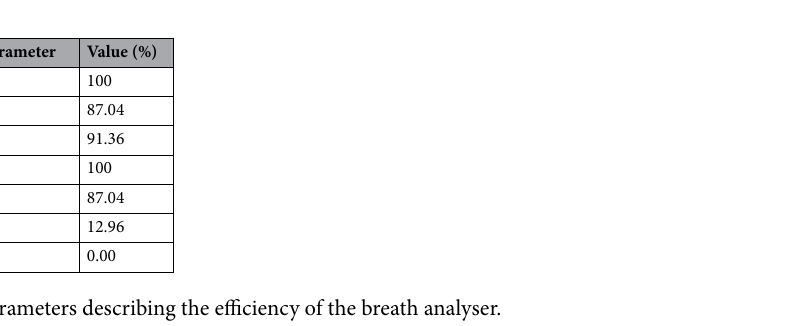
Figure 6. Ratiometric sensor output as recorded by the breath analyzer device for 84 subjects. The response is plotted as a ratio metric signal wherein in the signal is compared to the baseline.